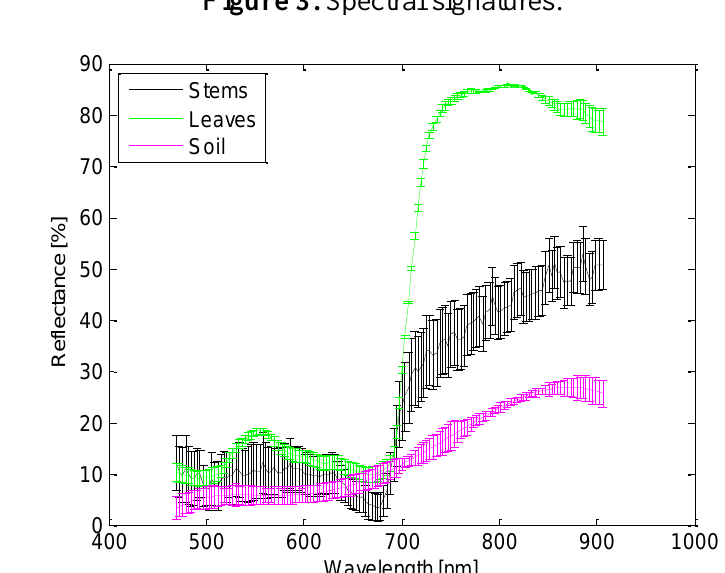
Figure 3. Spectral